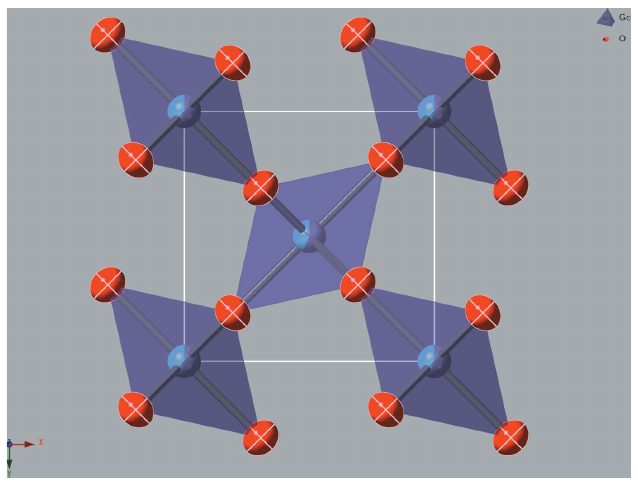
Figure 1 View of the structure of Ge 0.57 Ti 0.43 O 2 looking down the c axis. The unit cell is outlined in white. The red ellipsoids represent the oxygen atoms and show the orientation of the displacement ellipsoids for 99% probability. The Ti atom is represented by light blue and the Ge atom by purple, with the percentage occupancy of the M site represented as a pie chart on the atom. M O 6 octahedra are represented as transparent